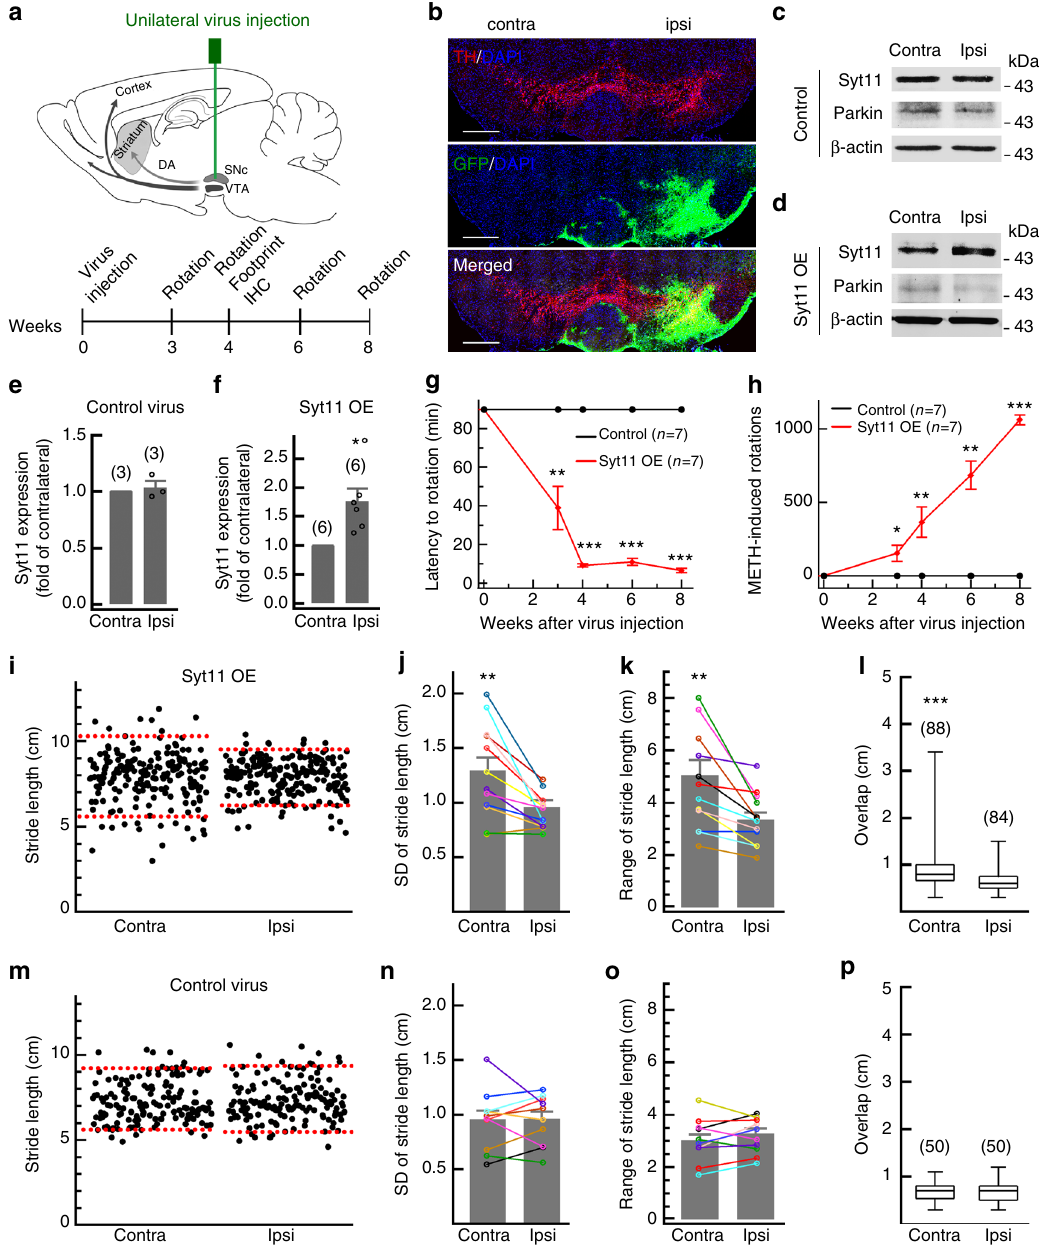
Fig. 2 Unilateral Syt11 overexpression in the SNpc induces motor abnormalities. a Schematic of unilateral virus injection in the SNpc and time course of experiments. b Representative micrograph of TH staining in an SNpc-containing slice showing that GFP-carrying lentivirus was precisely injected into the SNpc (ipsi) and ef fi ciently infected the dopaminergic neurons. Scale bars, 500 μ m. c – f Representative western blots and statistics showing the expression of Syt11 in the bilateral SNpc from mice overexpressing (OE) Syt11 unilaterally and controls 1 month after virus injection (Control, P = 0.691; Syt11-OE, P = 0.022). g , h Methamphetamine (METH) induces progressive asymmetric rotation (rotation latency and rotations in 90 min) of mice with unilateral OE of Syt11 in the SNpc, compared with control virus (latency, P = 0.022, 0.000, 0.000, and 0.000 for 3, 4, 6, and 8 weeks; rotation, P = 0.020, 0.007, 0.003, and 0.000 for 3, 4, 6, and 8 weeks). i – l Footprint data showing the defect in contralateral motor stability of mice with unilateral Syt11-OE in the SNpc. Stride length ( i – k , SD, P = 0.003; range, P = 0.004) and front/hind footprint overlap ( l , P < 0.001, n = 88 Contra and 84 Ipsi steps from six mice) were quanti fi ed, and the dashed red lines in i represent the 5 and 95% percentiles of stride length. m – p Footprint data showing the normal motor stability of mice unilaterally expressing control virus in the SNpc (SD, P = 0.946; range, P = 0.347; foot overlap, P = 0.857, n = 50 Contra and 50 Ipsi steps from six mice). Contra, contralateral; Ipsi, ipsilateral. Data are shown as mean ± s.e.m. for e – h , j , k , n , o . Paired Student ’ s t -test for e , f , j , k , n , o ; unpaired Student ’ s t -test for g , h ; Mann – Whitney test for l , p , box and whisker plots show medians (central line in the box), ranges between 25th and 75th percentiles (box) and minimum – maximum ranges (whiskers). * P < 0.05, ** P < 0.01, *** P <